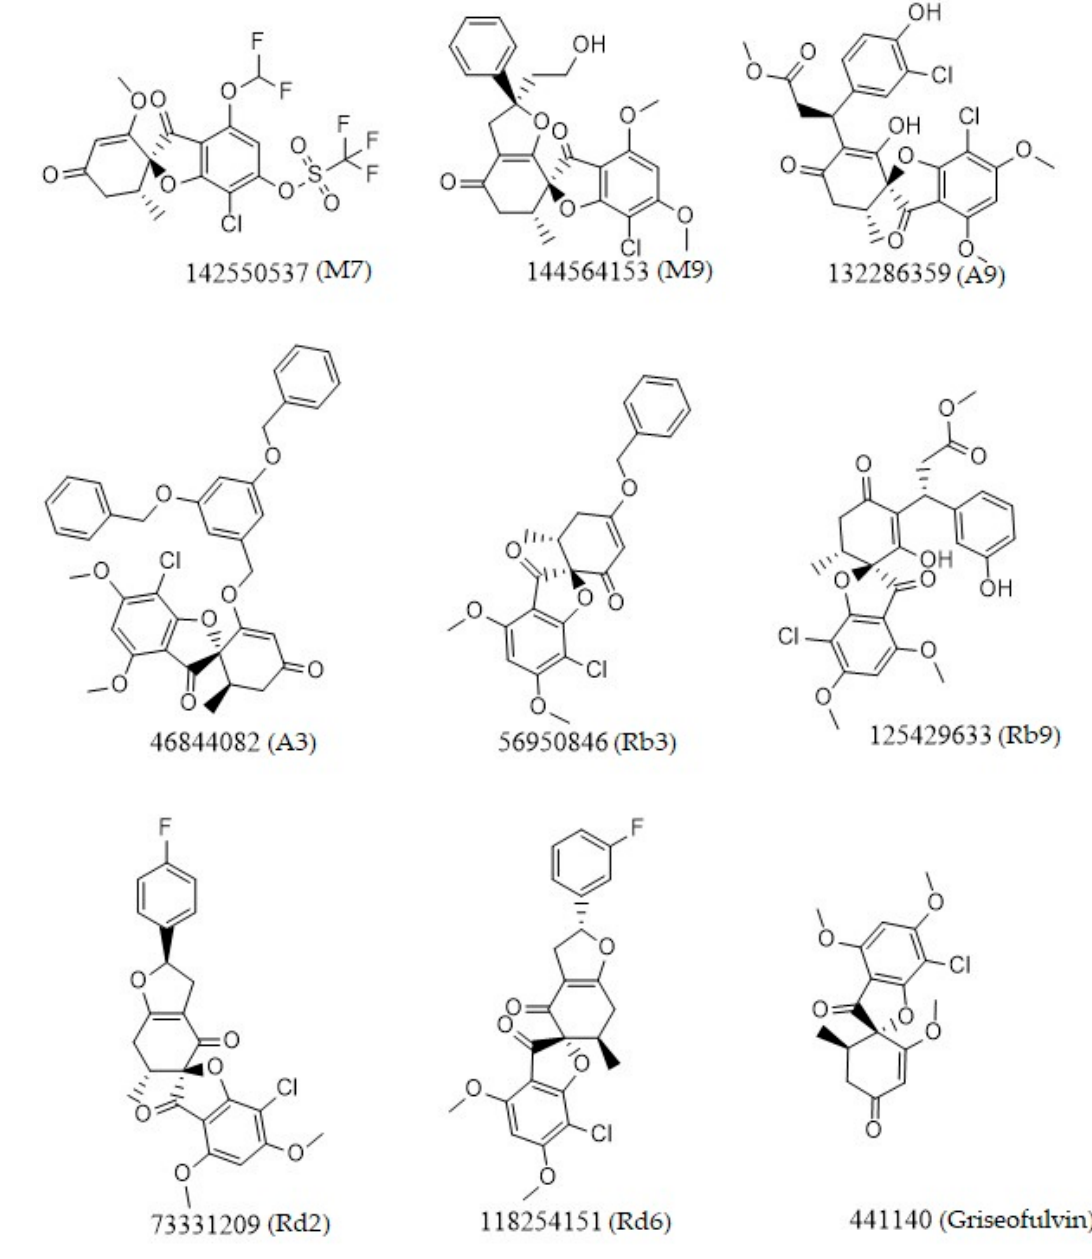
Figure 2. Chemical two-dimensional (2D) structures of the top ligands selected for MD analysis. The PubChem IDs are listed under the 2D structures. Table 2. The average of RMSD, RMSF, Rg, and SASA for M protease during the last 20 ns of